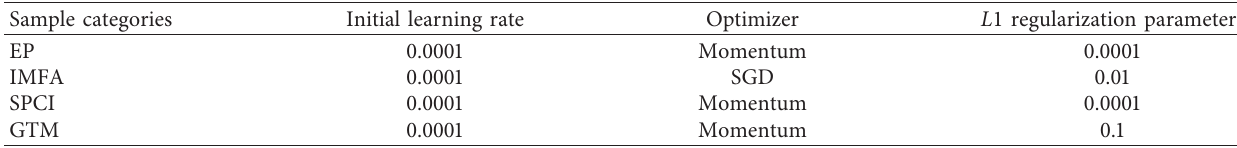
Figure 13: Performance curves of the model with λ � 0.0001: (a) accuracy; (b) loss. Table 8: Best parameter determination of four models.